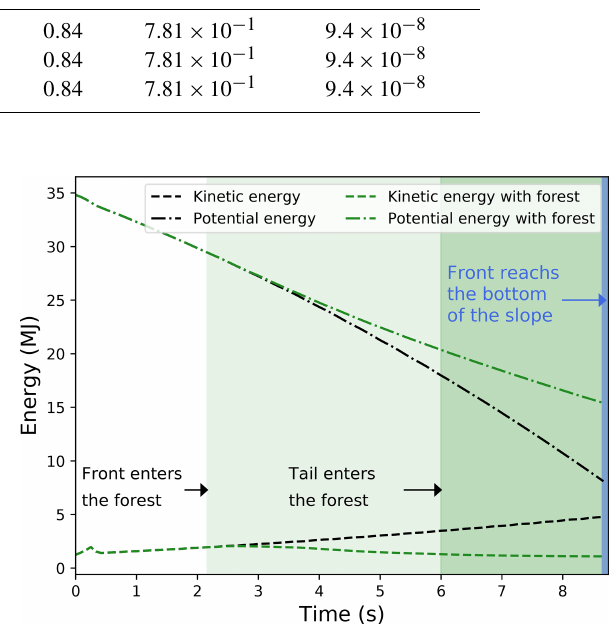
Figure 11. Temporal evolution of the kinetic and potential energy without forest and with a regular staggered forest (Case 2, v 0 = 6ms − 1